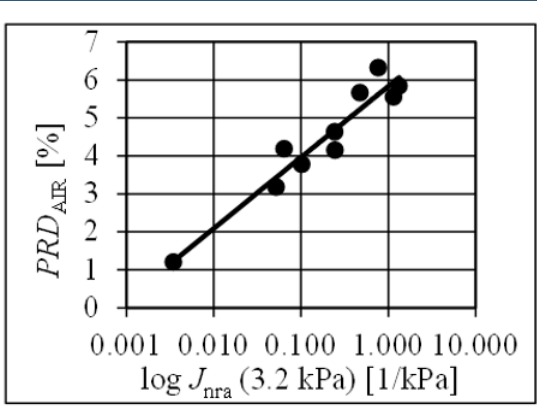
Figure 7. ProportionalmeanrutdepthofAC16asphaltmixesversus non-recoverable compliance of different